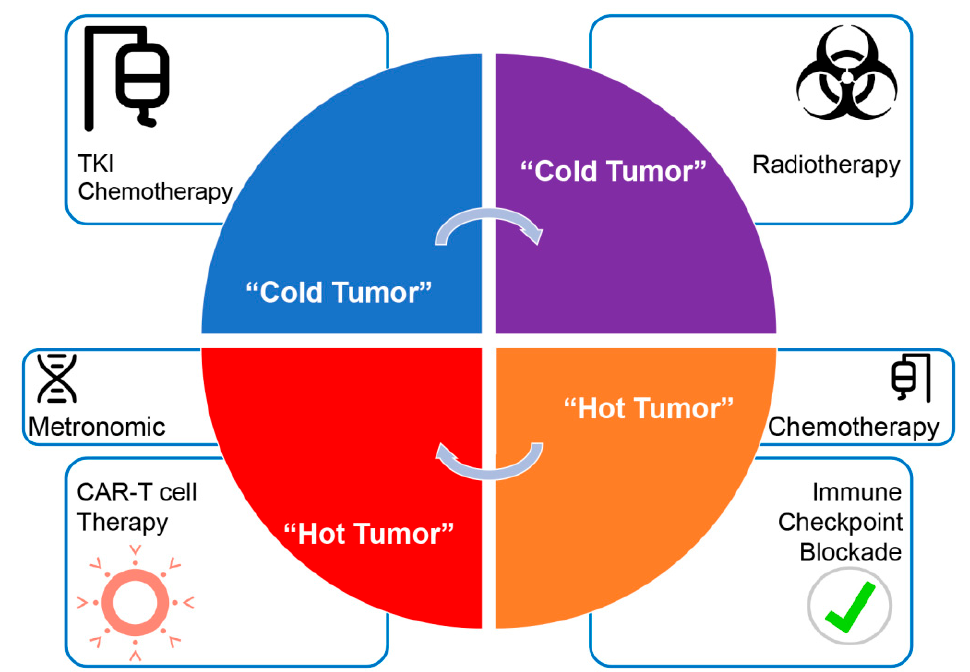
Figure 3. The focus of treatment shifts from killing tumor cells to treating the specific biologic characteristics of the tumor and its environment; this increases the intrinsic abilities of the immune system to combat cancer. Timing of ICIs and CAR-T cells therapy administration has to coincide with a high inflammatory tumor microenvironment to ensure presence and effectiveness of ICI-induced potential tumor-fighting CD8 + T lymphocytes and redirected CAR-T cells. Increased DNA damage and tumor necrosis provoked by prior conventional chemotherapy and radiotherapy may increase neo-antigen release and DCs processing leading to increased tumor antigenicity; tyrosine kinase inhibitors (TKI) administration may contribute to reduce the transcriptionally controlled secretion of immunosuppressive cytokines in the TME, while participating to cancer cell death; adopted metronomic chemotherapy may help survival and functionality of immune cells while maintaining efficiency of the endothelial-cells/vessels compartment during immunotherapy.